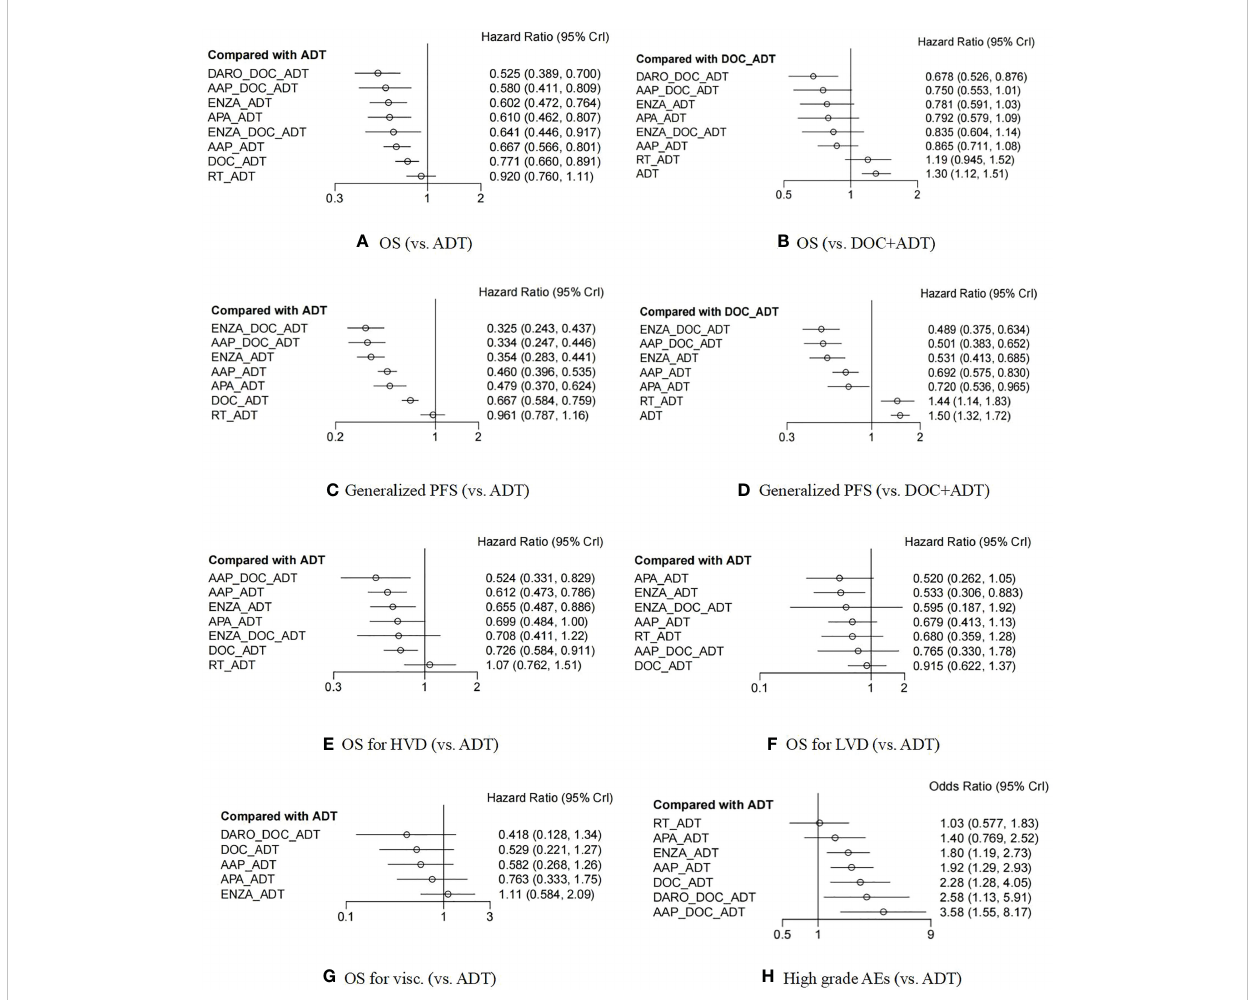
FIGURE 3 Forest plot between different treatment options and ADT monotherapy (or DOC+ADT) in patients with metastatic hormonal-sensitive prostate cancer (A – H) . ADT, androgen deprivation treatment; DOC, docetaxel; AAP, abiraterone acetate and prednisone; ENZA, enzalutamide; APA, apalutamide; RT, radiotherapy; DARO, darolutamide; OS, overall survival; PFS, progression free survival; HVD, high volume disease; LVD, low volume disease; Visc., patients with visceral metastasis; AEs, adverse events. The connector line “ _ ” represents combination of different treatment